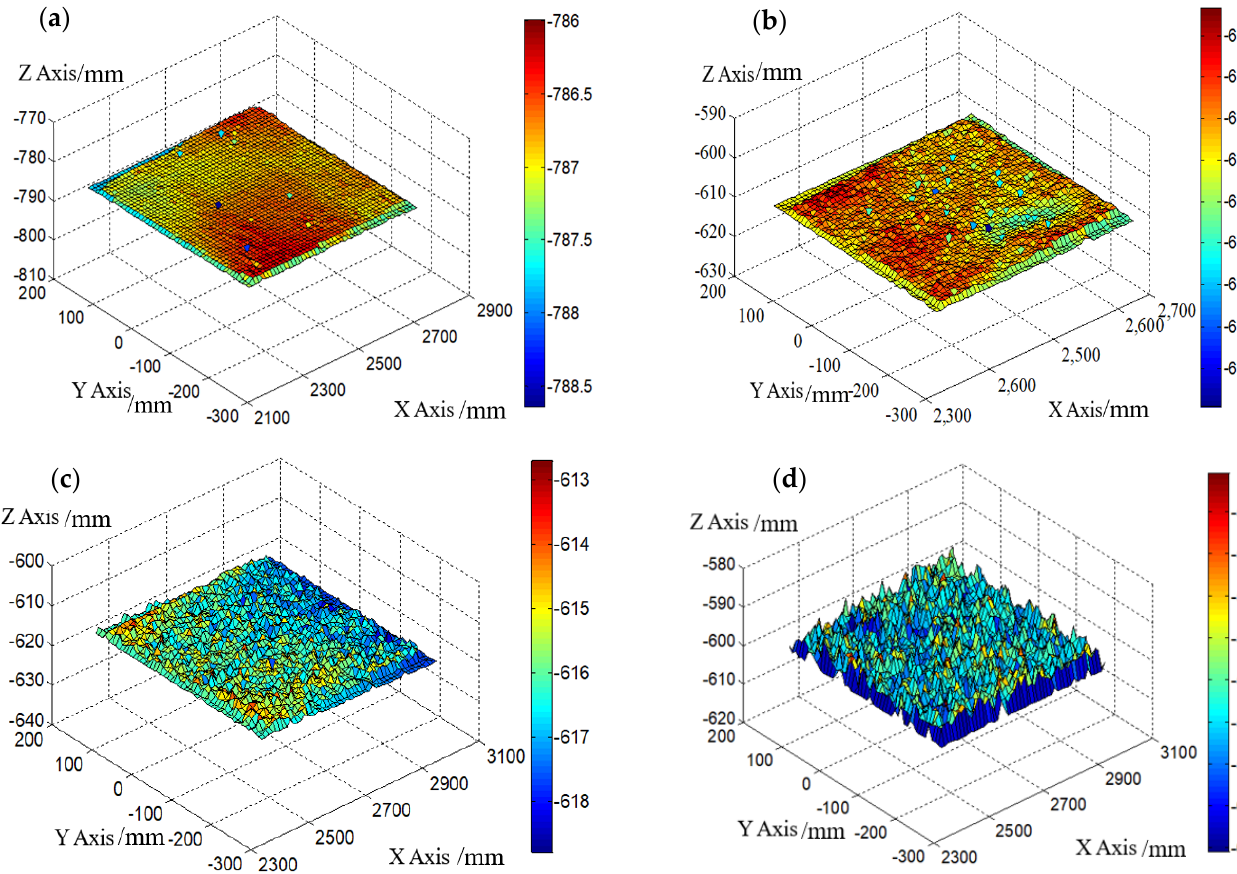
Figure 9. Reconstruction of the concrete plate surfaces corroded for 0, 31, 93, and 154 days in Matlab. (a) Concrete plate uneroded; (b) Concrete plate eroded for 31 days; (c) Concrete plate eroded for 93 days; (d) Concrete plate eroded for 154 days.